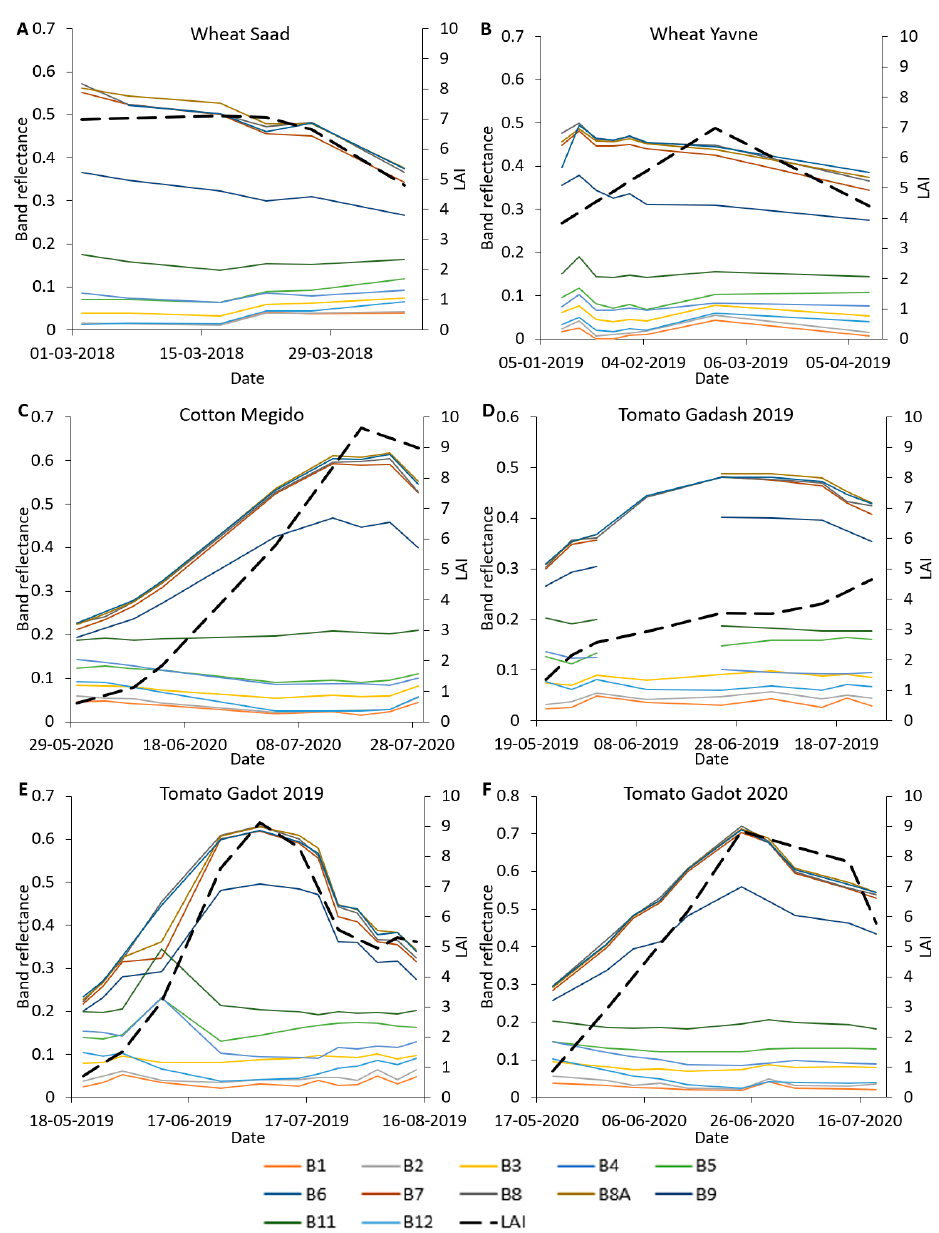
Figure 3. Band reflectance and LAI measurements in the following experiments: ( A ) Wheat Saad, ( B ) Wheat Yavne, ( C ) Cotton Megido (centre of field), ( D ) Tomato Gadash 2019, ( E ) Tomato Gadot 2019, ( F ) Tomato Gadot 2020.